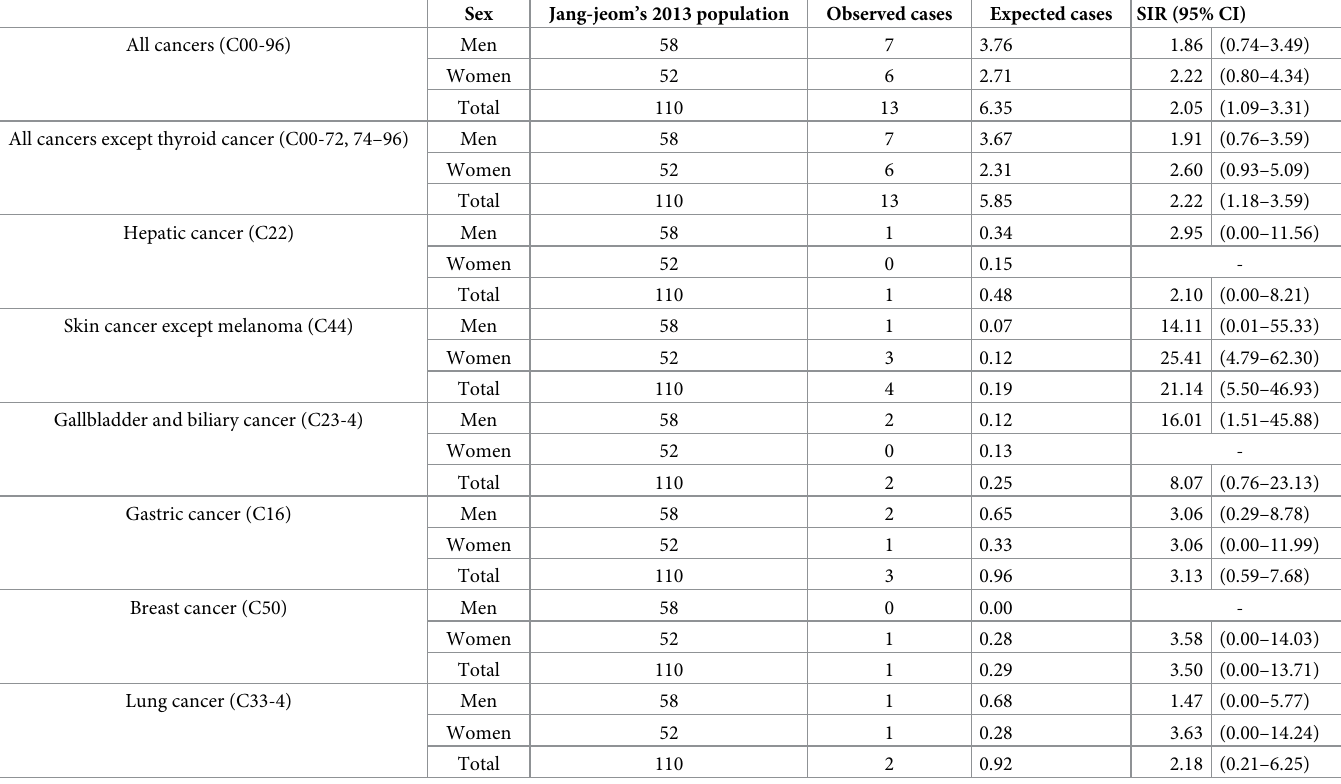
Table 1. The cancer standardized incidence ratio of the Jang-jeom village compared to the whole of Korea in